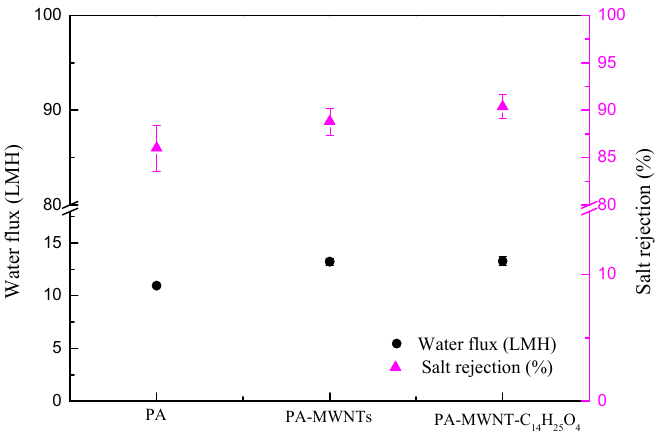
Figure 8. Water flux and salt rejection of the PA membrane and PA-CNT-composite membranes. (2000 ppm of NaCl feed solution, 1.0 MPa of feed pressure).